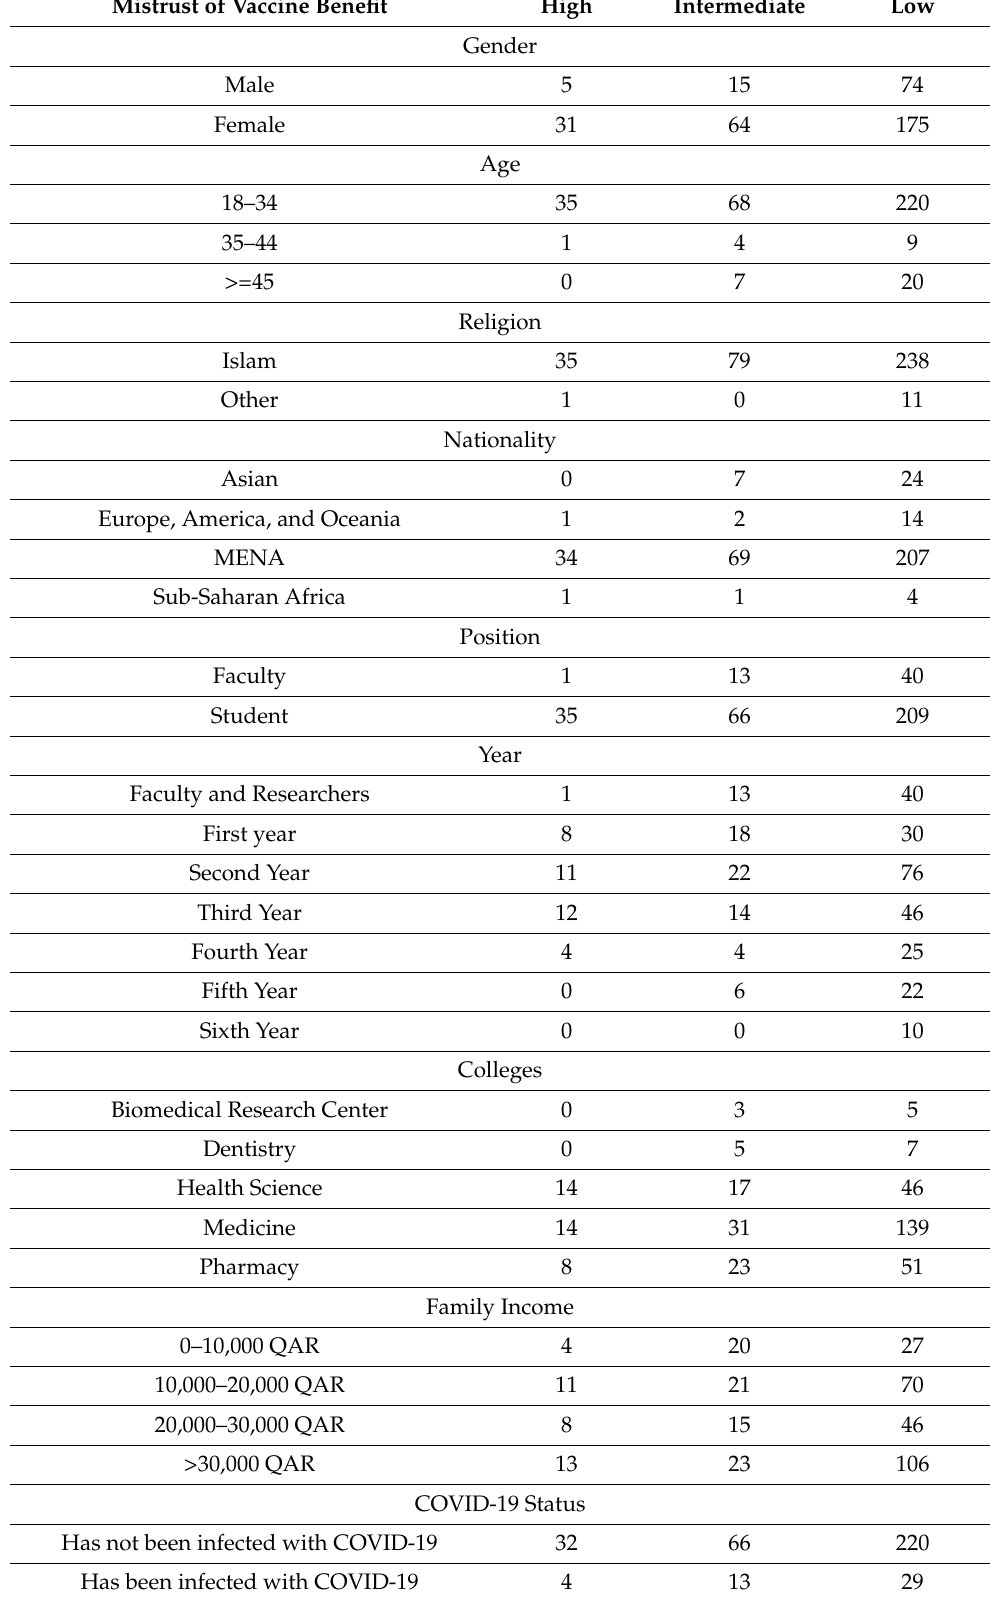
Table A2. Actual number of participants in Mistrust of Vaccine Benefit